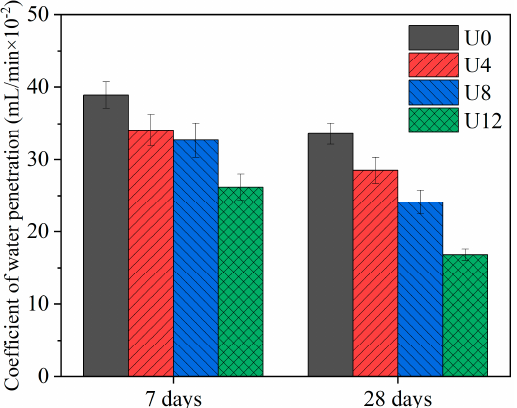
Figure 6. Coefficient of water penetration at 7 and 28 days.